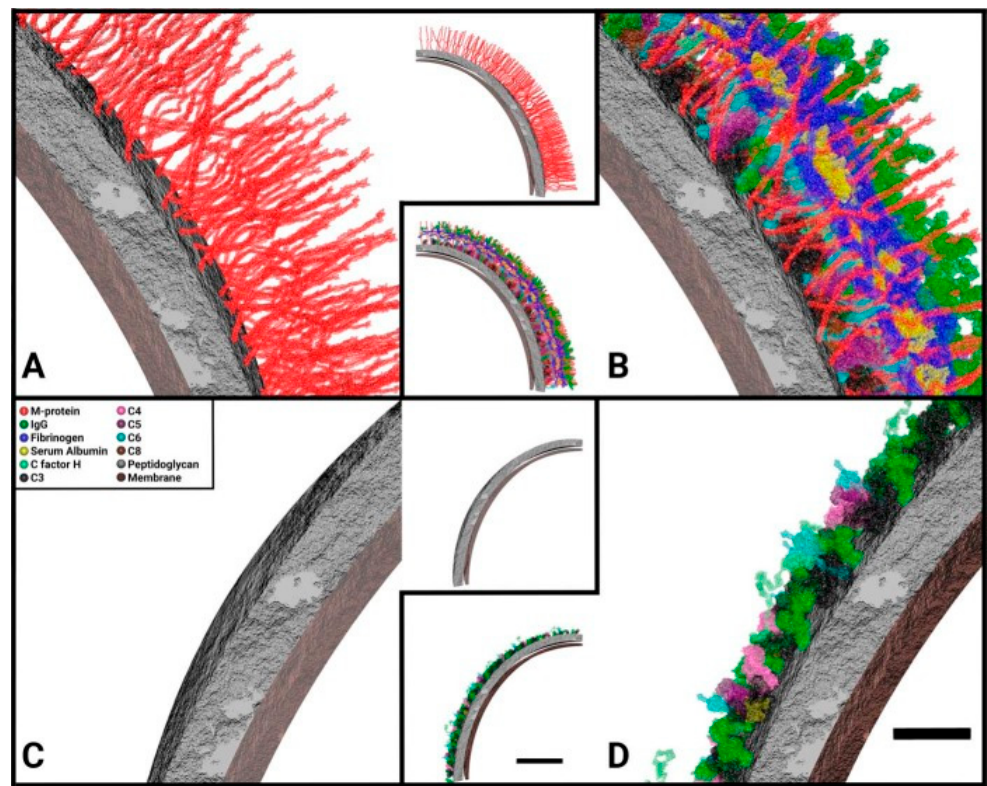
Figure 3. The stoichiometric surface density models of Streptococcus pyogenes —human plasma interactions. ( A ) The S. pyogenes surface ( B ) with plasma adsorbed to the surface; ( C ) the S. pyogenes -M1-deletion mutant; and ( D ) S. pyogenes with plasma adsorbed to surface. Selective Reaction Monitoring (SRM)-MS, which counted the number of bacteria, was used to build the model of S. pyogenes ’s surface interaction network in a host environment. The model was based on stoichiometric relations between host proteins, surface proteins, and the surface of the pathogen. This research was originally published in Molecular & Cellular Proteomics . Sjöholm et al. Targeted proteomics and absolute protein quantification for the construction of a stoichiometric host–pathogen surface density model. Mol Cell Proteomics 2017 , 16, S29-S41 © the American Society for Biochemistry and Molecular Biology. Reprint from [11] with permission. All rights reserved.